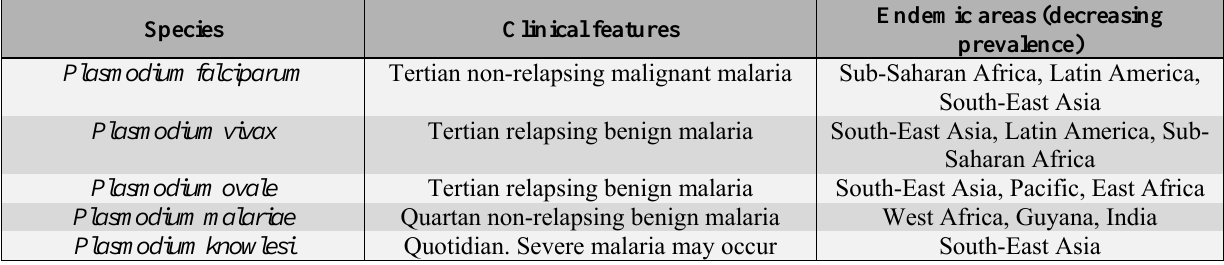
Table 1. Clinical features and geographical distribution of Plasmodia species ( reference [ 6], modified ) .